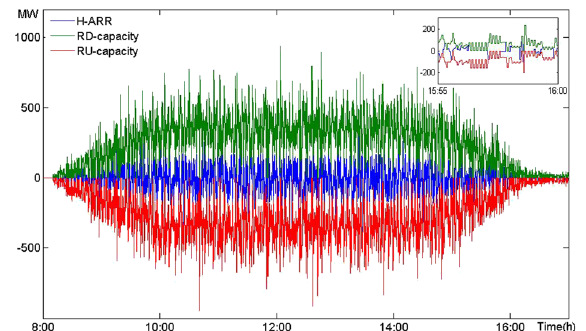
Fig. 11 The dispatch of H-ARR within the capacity of EVs for regulation